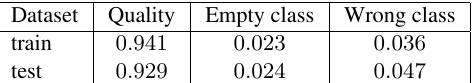
Table 1: Quality of gestures